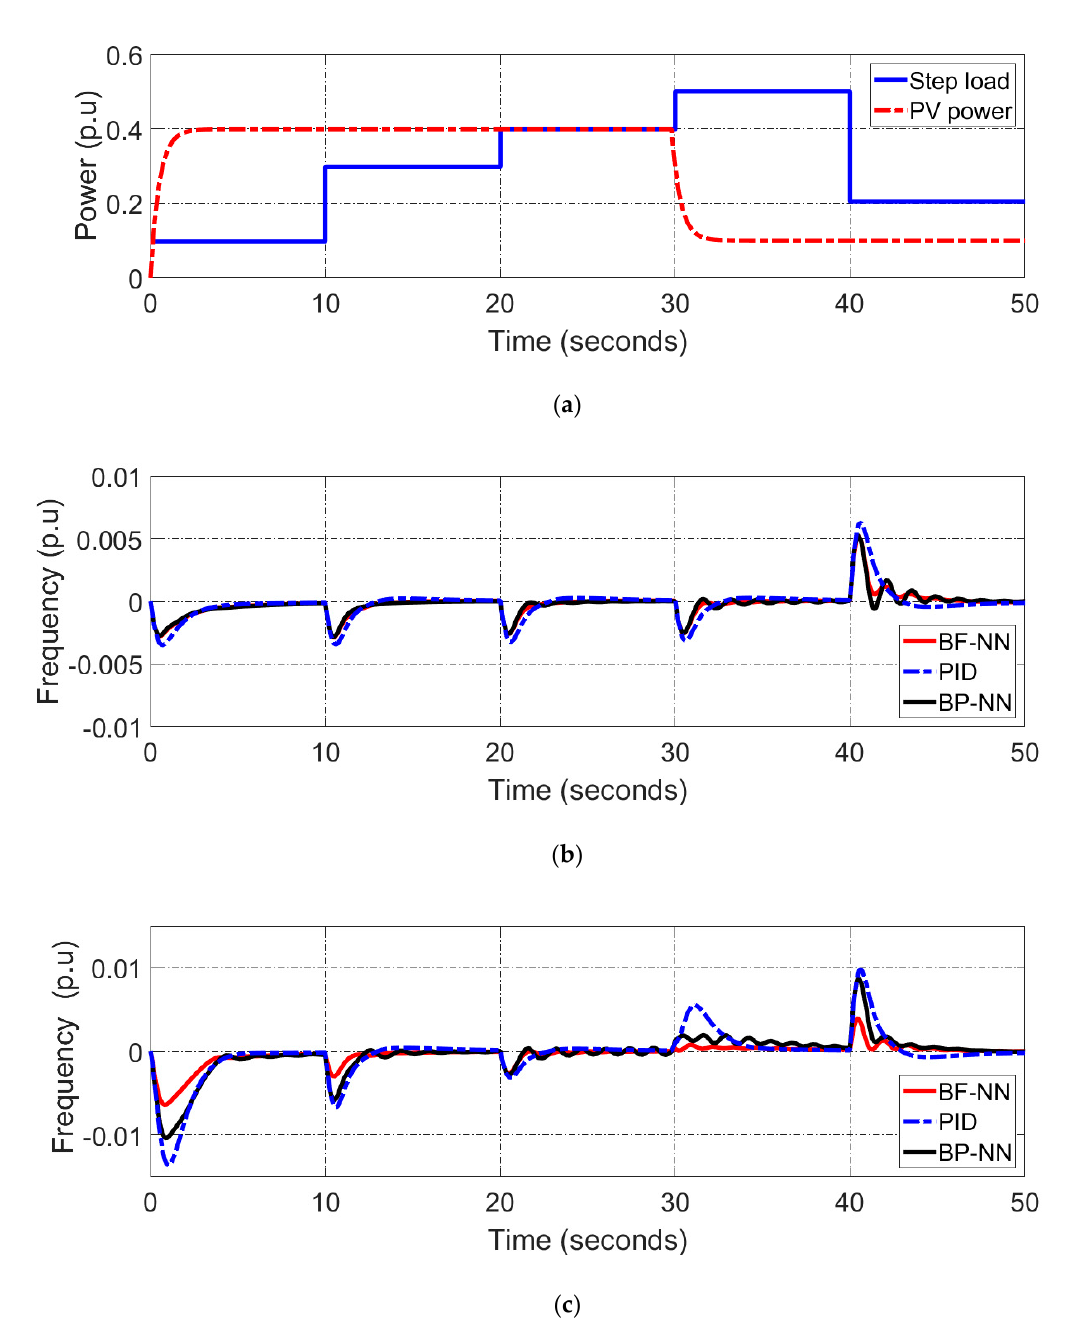
Figure 11. Division signals in a variable operating state of ( a ) input power, ( b ) output frequency without PV generation, and ( c ) output frequency with PV generation.